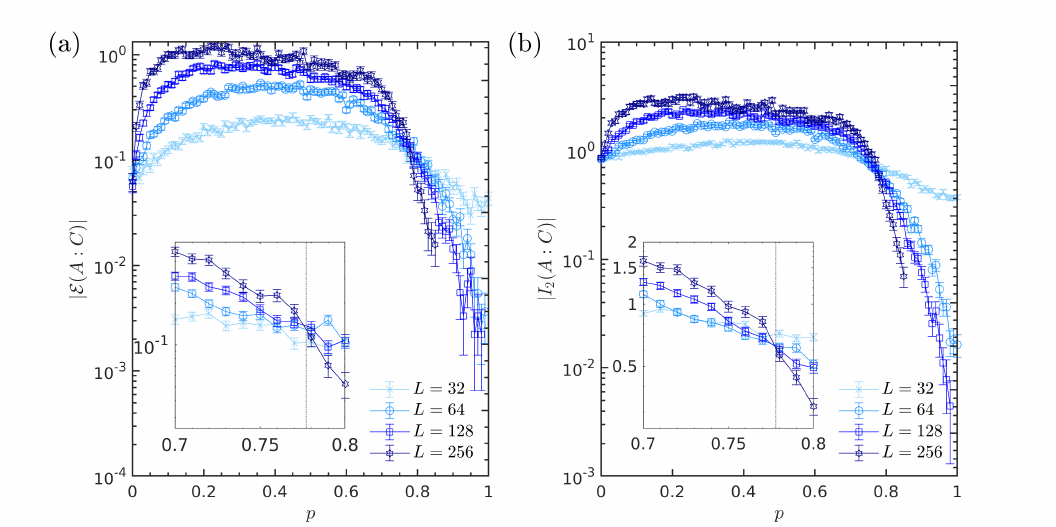
Figure 6: Comparison of negativity and MI as a function of p for M = 4. (a) The = 0.778 for larger system sizes. behavior of negativity w.r.t p shows a crossing at p c (b) The plot of MI versus p displays a similar behavior as that of negativity with crossing at the same p . The dashed-dotted line shows the crossing point p c c